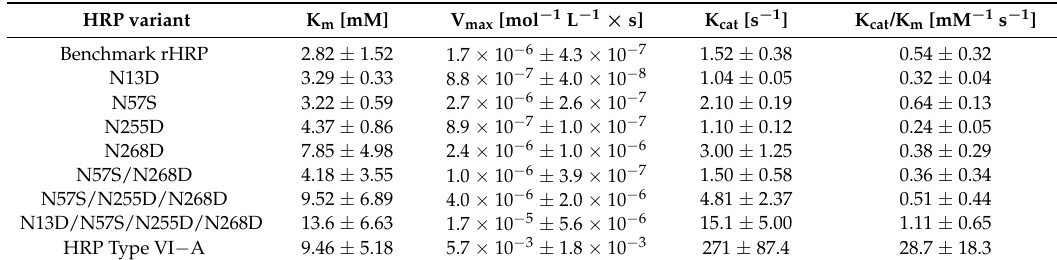
Table 2. Kinetic characteristics of plant HRP, rHRP and seven rHRP variants with ABTS as reducing